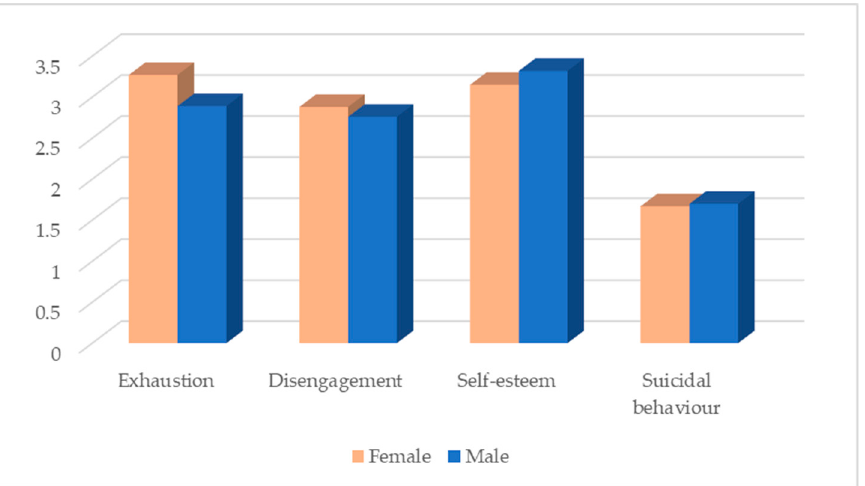
Figure 2. Distribution of the variables under study according to gender .